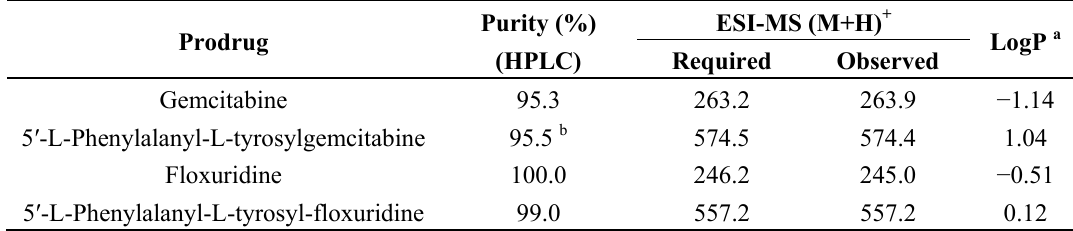
Table 1. Analytical data for dipeptide ester prodrugs of floxuridine and